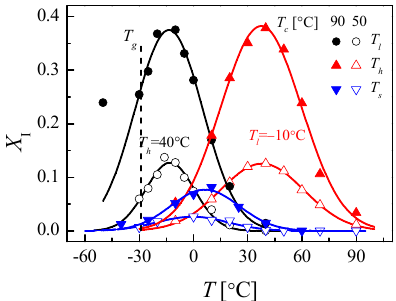
40 °C. The quick transformation at low temperature in the early stage was related to a faster expected at higher temperatures. In conclusion, the optimal temperatures for the nucleation or first at −10 °C for short time to induce the nuclei and then at 40 °C to promote the form I crystal growth provides an ideal pathway for accelerating the solid-phase of iPBu.